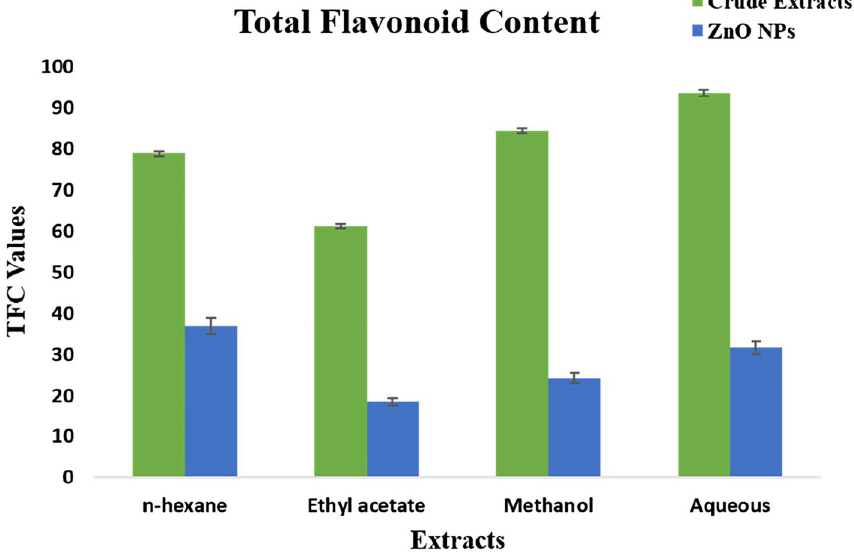
Figure 4. Total flavonoid content of F.cretica crude extracts and its synthesized ZnO NP. Values given are expressed as the mean of triplicate ± standard deviation.